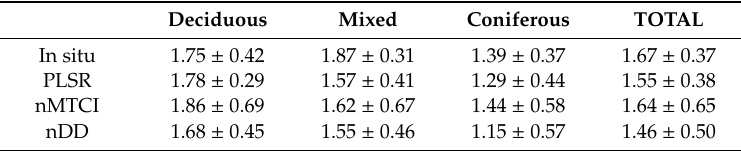
Table 3. Mean and standard deviation of in situ and estimated canopy chlorophyll content (g/m 2 ) using the three selected models for standing deciduous, mixed, and coniferous forest stands.